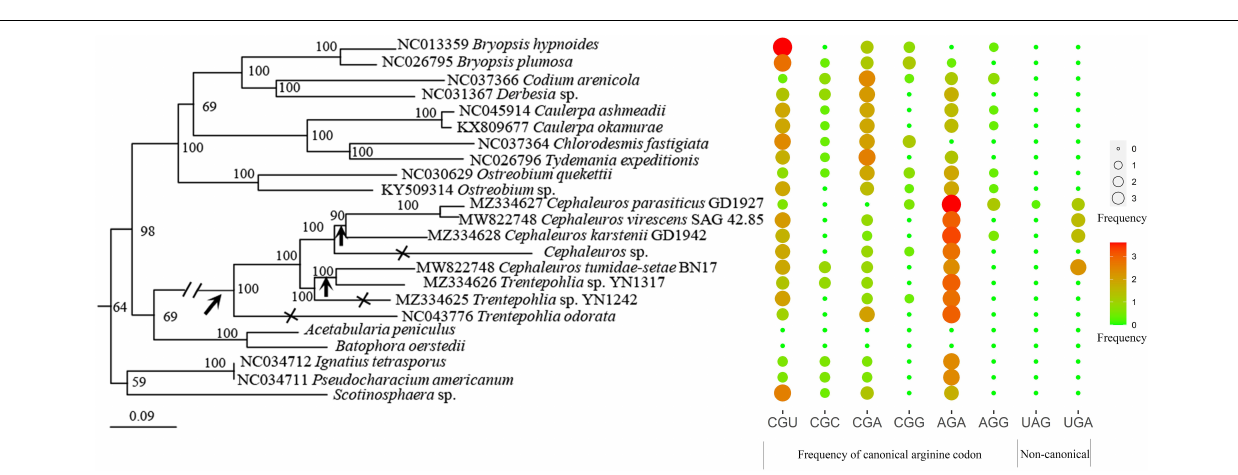
FIGURE 4 | The estimated frequencies of arginine codon usage. Canonical codon AGA is most commonly used, followed by other canonical codon CGU. Among the non-canonical codons, UGA is used more commonly then UAG. (1) A single origin of the non-canonical code along the branch leading to C. parasiticus , C. virescens , C. karstenii , C. tumidae-setae , and Trentepohlia sp. YN1317, and a subsequent reversal to the standard code in Cephaleuros sp., Trentepohlia sp. YN1242, and Trentepohlia odorata (indicated with oblique arrow and cross). (2) A stepwise process of evolution of the non-canonical code with a single initiation of the process along the branch leading to C. parasiticus , C. virescens , C. karstenii , C. tumidae-setae , and Trentepohlia sp. YN1317, followed by a completion of the process in all species except Cephaleuros sp., Trentepohlia sp. YN1242 and Trentepohlia odorata (oblique arrow combined with vertical arrow). (3) Two